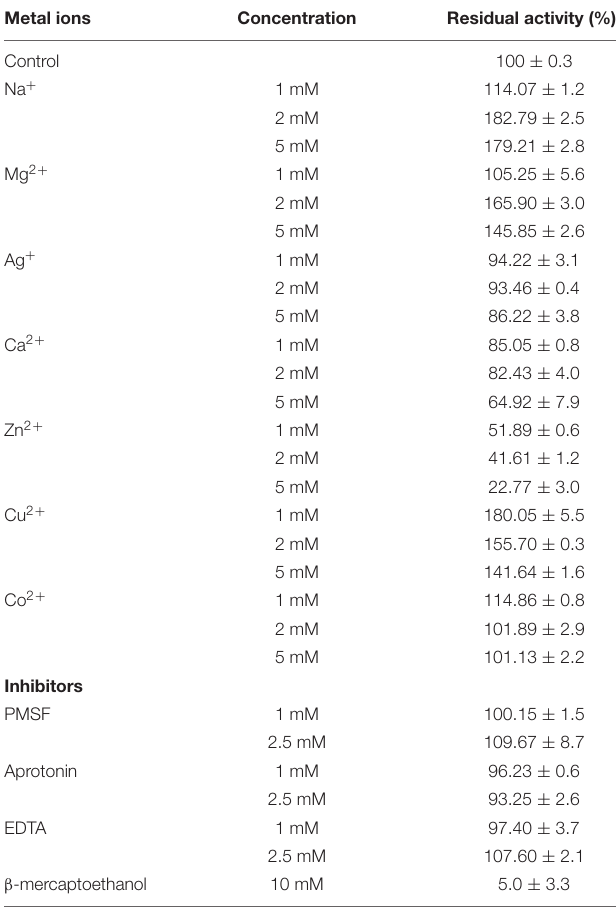
TABLE 2 | Effect of metal ions and inhibitors on activity of PyCP. Metal